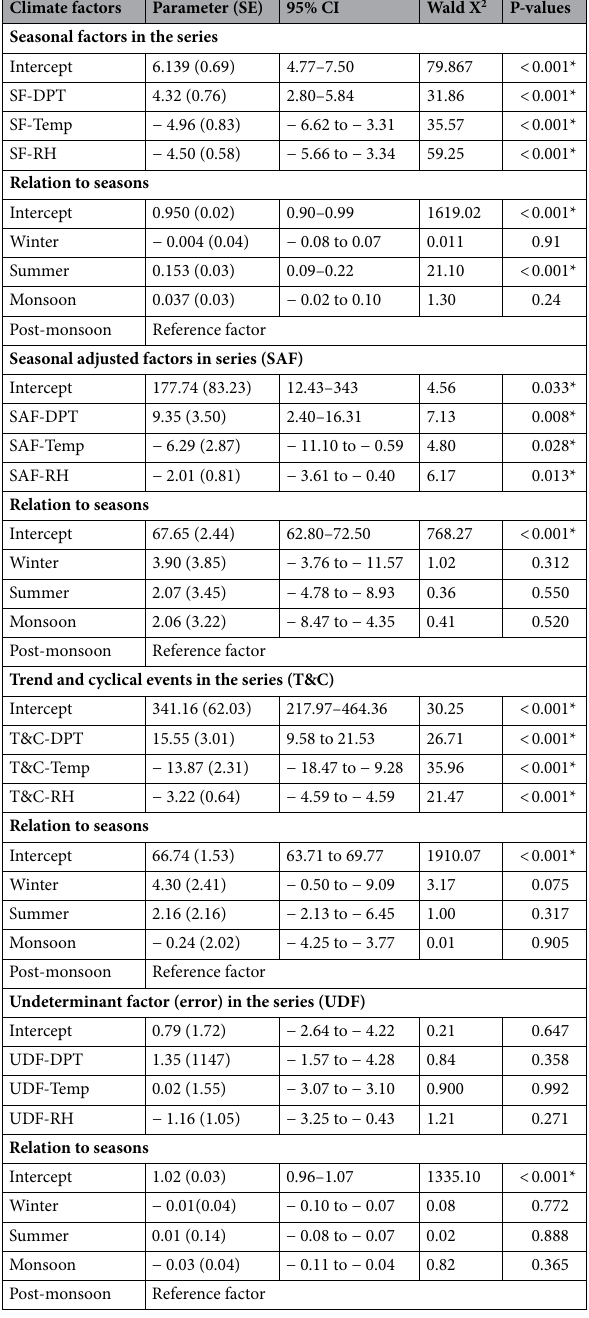
Table 2. Generalized linear model exploring the TB and climate factor relation. DPT Dew point temperature, Temp temperature, RH relative humidity. *Statistically